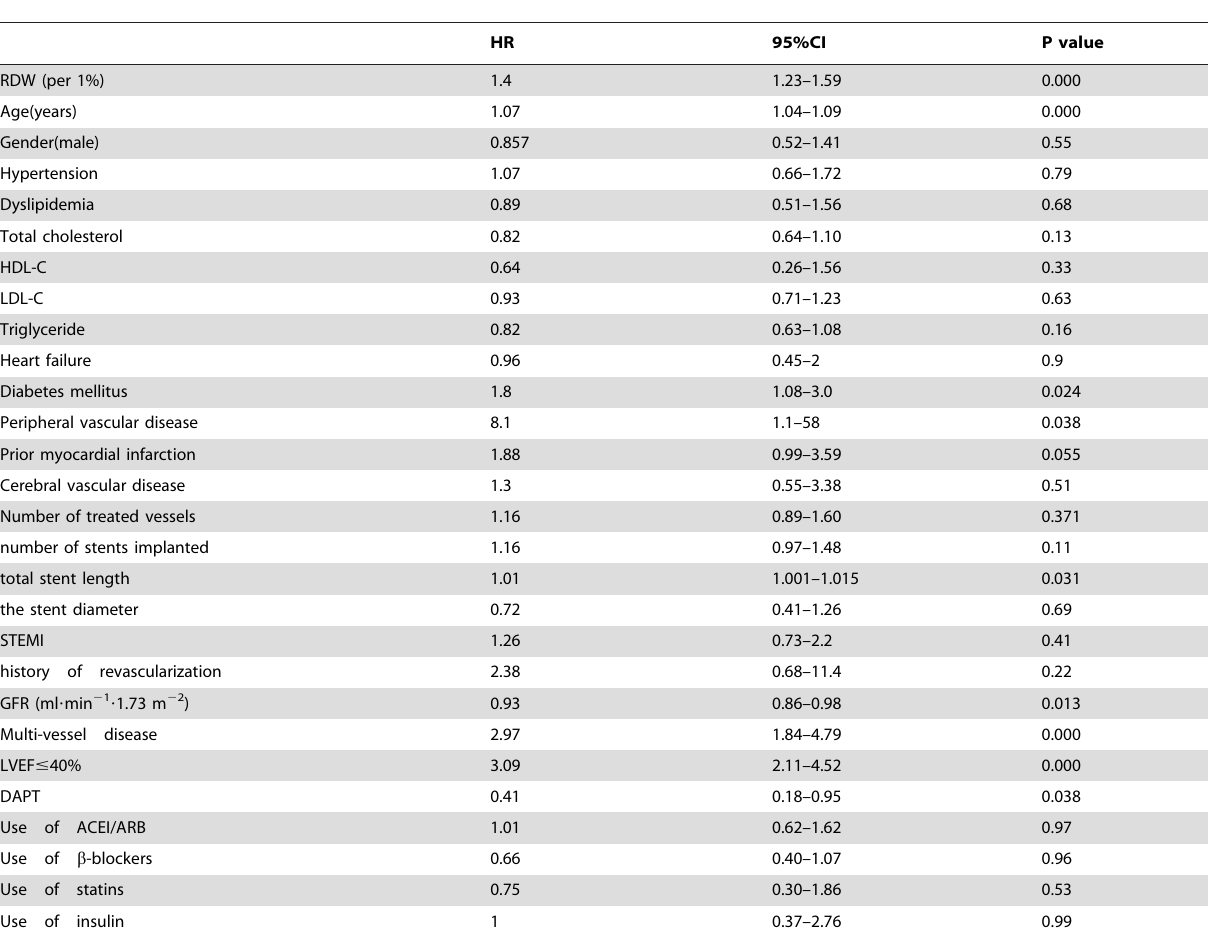
Table 4. Univariate Analysis for All-Cause